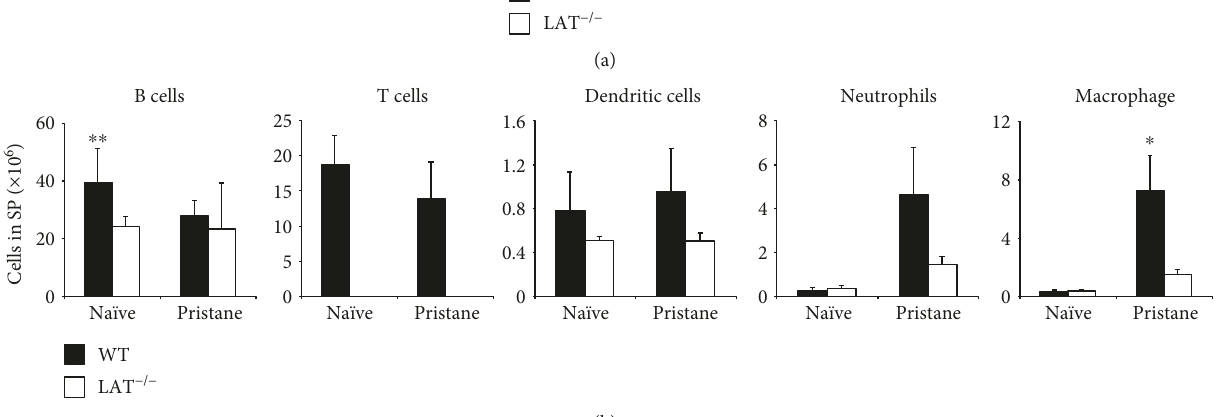
Figure 7: T cell loss inhibits splenic macrophage recruitment during pristane-induced splenic in fl ammation. (a, b) LAT − / − mice and WT mice were injected with 300 μ L (8.3 × 10 − 4 mol) of pristane and sacri fi ced at three weeks thereafter. Total number of cells and the number of each cell type were calculated. The di ff erence between WT and LAT − / − mice is shown. Data represent two independent experiments. ∗ p < 0 05 and ∗∗ p < 0 01